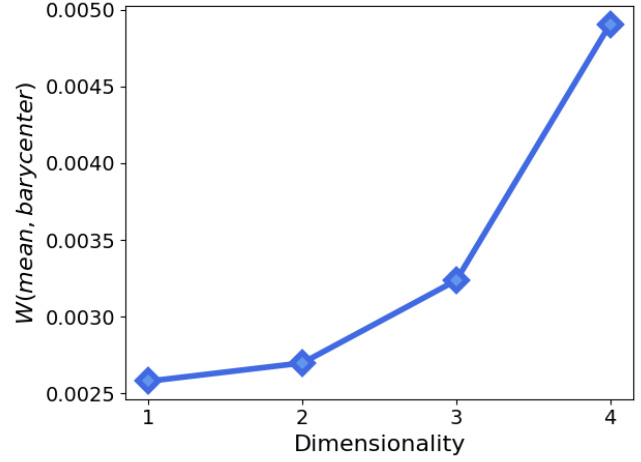
Figure 10. Distance between the Euclidean mean and the Wasserstein barycenter as the histograms’ dimensionality increases. The dimensionality of the histograms is on the x-axis, and the Wasserstein distances between the Euclidean mean of the histograms and their Wasserstein barycenters are on the y-axis.